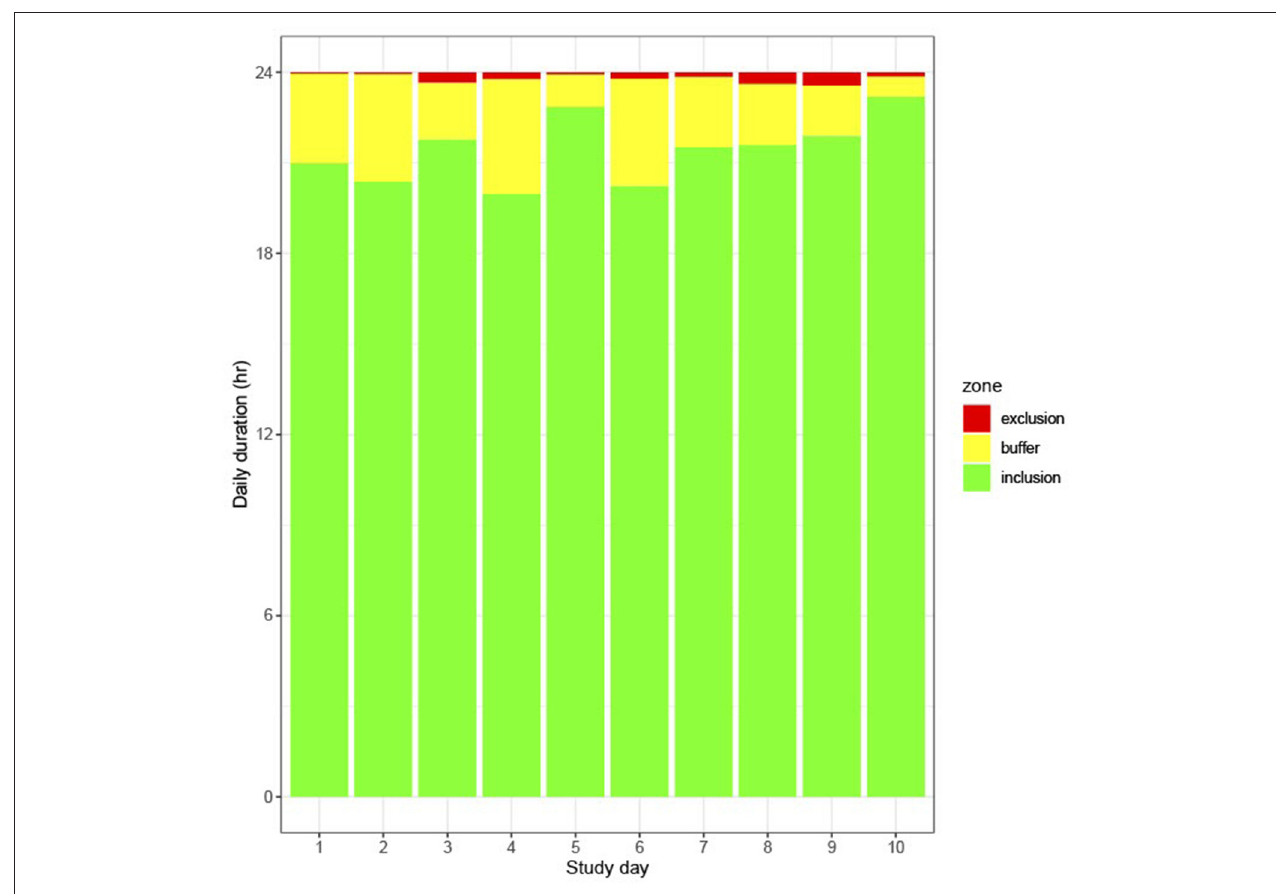
FIGURE 6 | Daily duration spent in each zone across days (1–10) based on averages derived from the raw